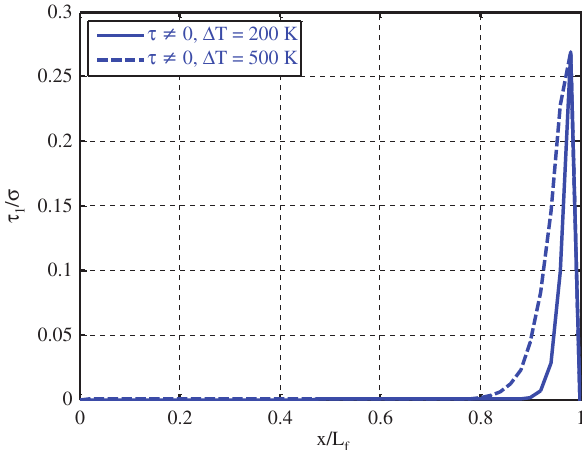
Figure 9: Variation of the transverse shear stress at the interface between the interlayer and the carbon fiber along its